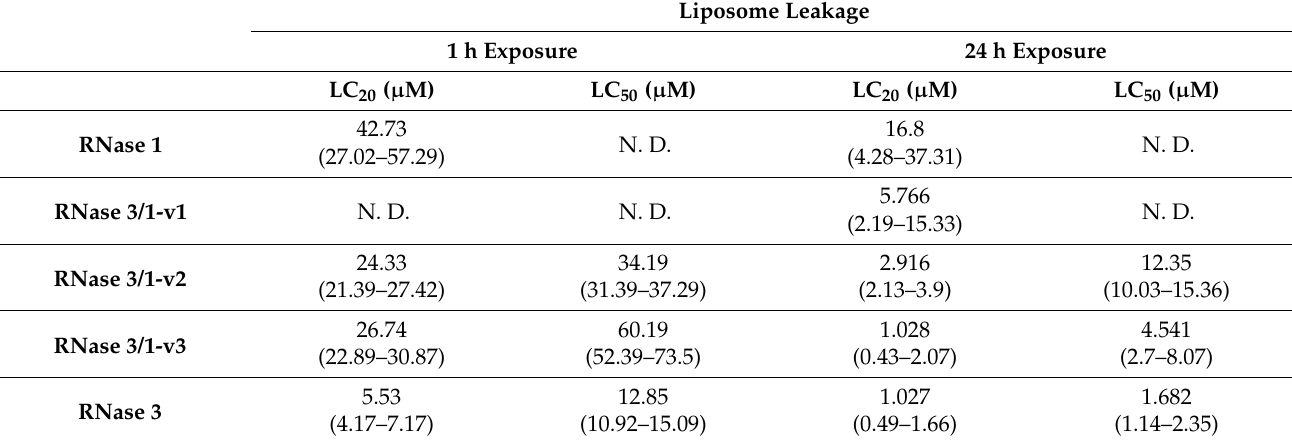
Table 4. Liposome leakage activity of RNases 1, 3 and the three versions of RNase 3/1. DOPC/DOPG (3:2) liposomes were prepared as described in the methodology. The values in parentheses represent the 95% confidence interval. Liposome leakage was measured as the protein concentration that induces 20% or 50% of liposome leakage (LC 20 and LC 50 , respectively), using a dose-response curve adjusted by GraphPad Prism 9 (Graph Pad, San Diego, CA, USA). Experimental data plots are shown in Figure S4. N. D.: not detected at the concentrations